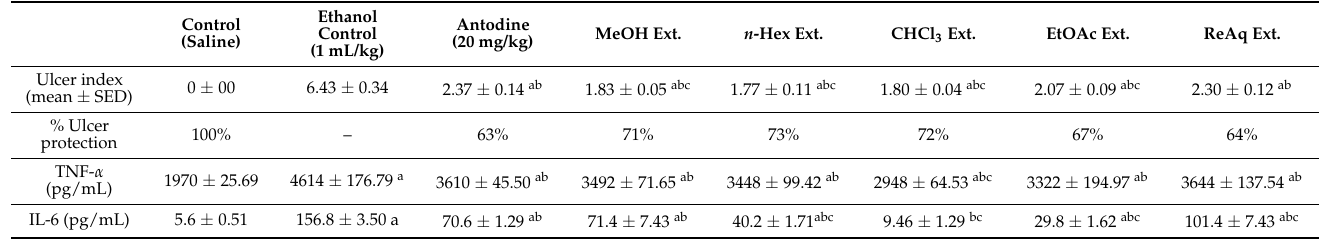
Table 4. Effect of the different extracts of E. erinaceus (500 mg/ kg) on ethanol-induced ulcers and on the gastric contents of TNF- α and